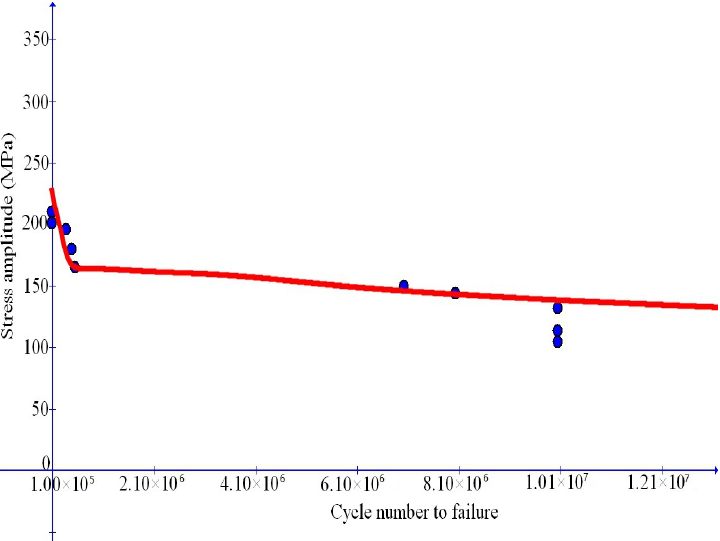
Figure 7. Comparison of simulation results with fatigue failure data (dots) from Sivananth et al. [7] for unreinforced LM6